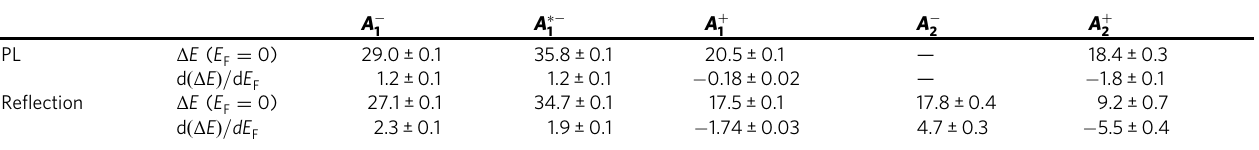
Δ E ( E ¼ 0) denotes the energy separation (in the unit of meV) between the exciton and exciton polaron at the charge neutrality point. d ð Δ E Þ = d E F energy ( E F